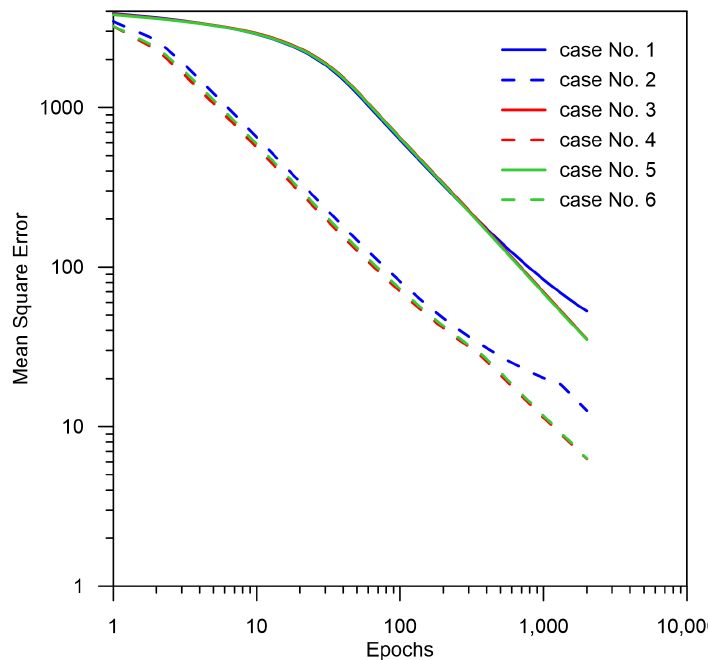
Figure 7. The training error history for different network